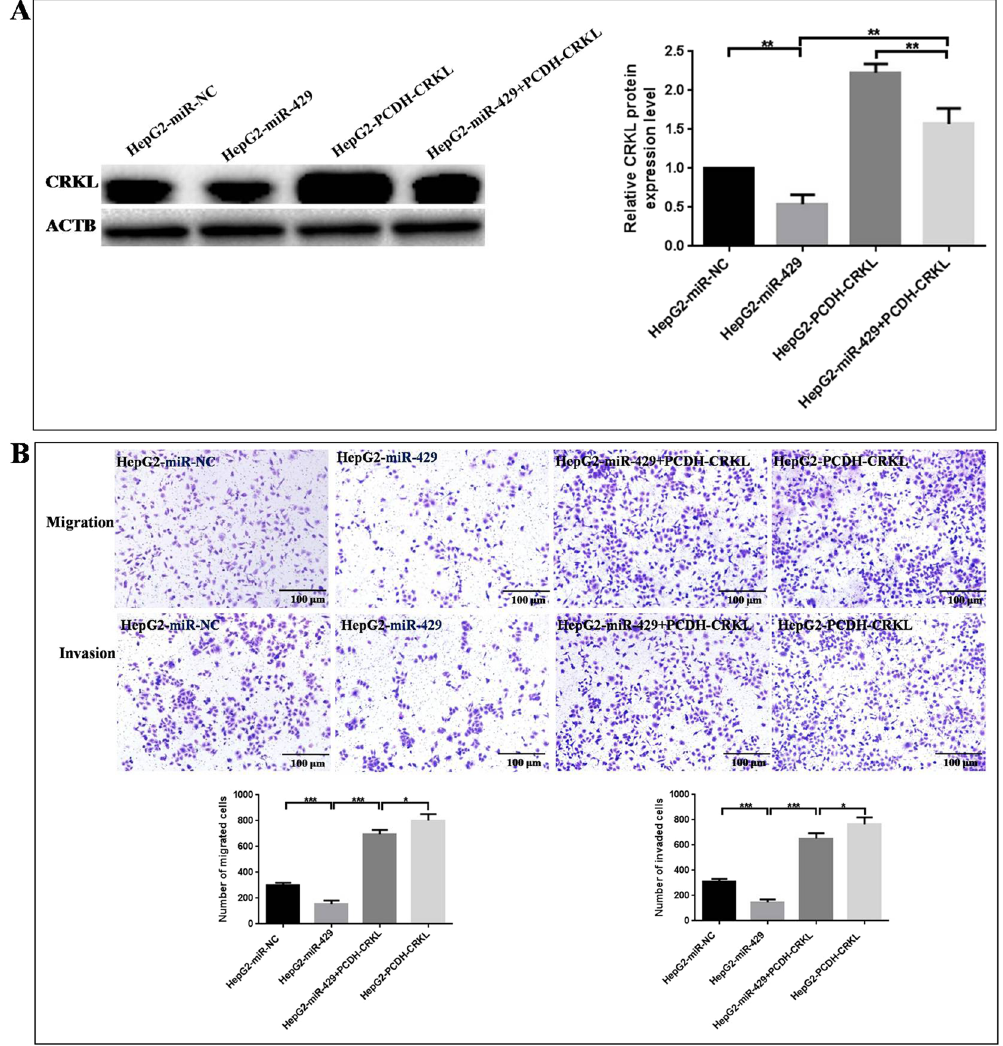
Figure 8. CRKL overexpression reversed miR-429-induced suppression on the in vitro migration and invasion of HepG2. ( A ) Expression level comparisons of CRKL in HepG2 cells transfected with miR-NC, miR-429 mimic, PCDH-CRKL and miR-429 + PCDH-CRKL. ( B ) CRKL overexpression neutralized miR-429-induced inhibition on the migration and invasion of HepG2 cells. * , ** and *** means the difference is with a P value below 0.05, 0.01 and 0.001 compared with the